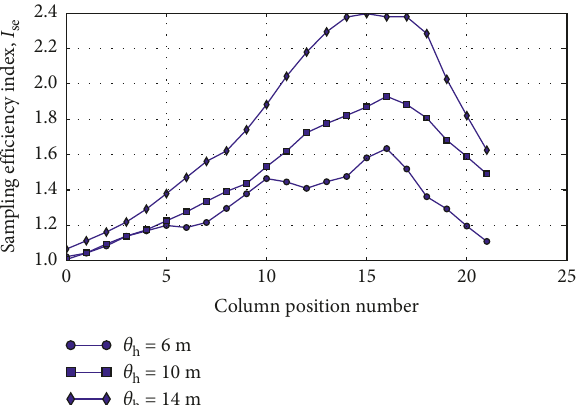
Figure 8: Sampling efficiency indices at different sampling locations for various values of θ